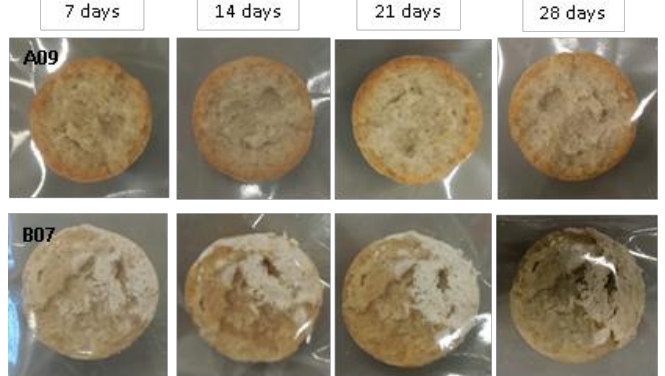
Figure 6. Examples of bread made from sourdoughs inoculated with the isolates A09 and B07, and then artificially contaminated with Aspergillus flavus and incubated at room temperature for 7, 14, 21, and 28 days.